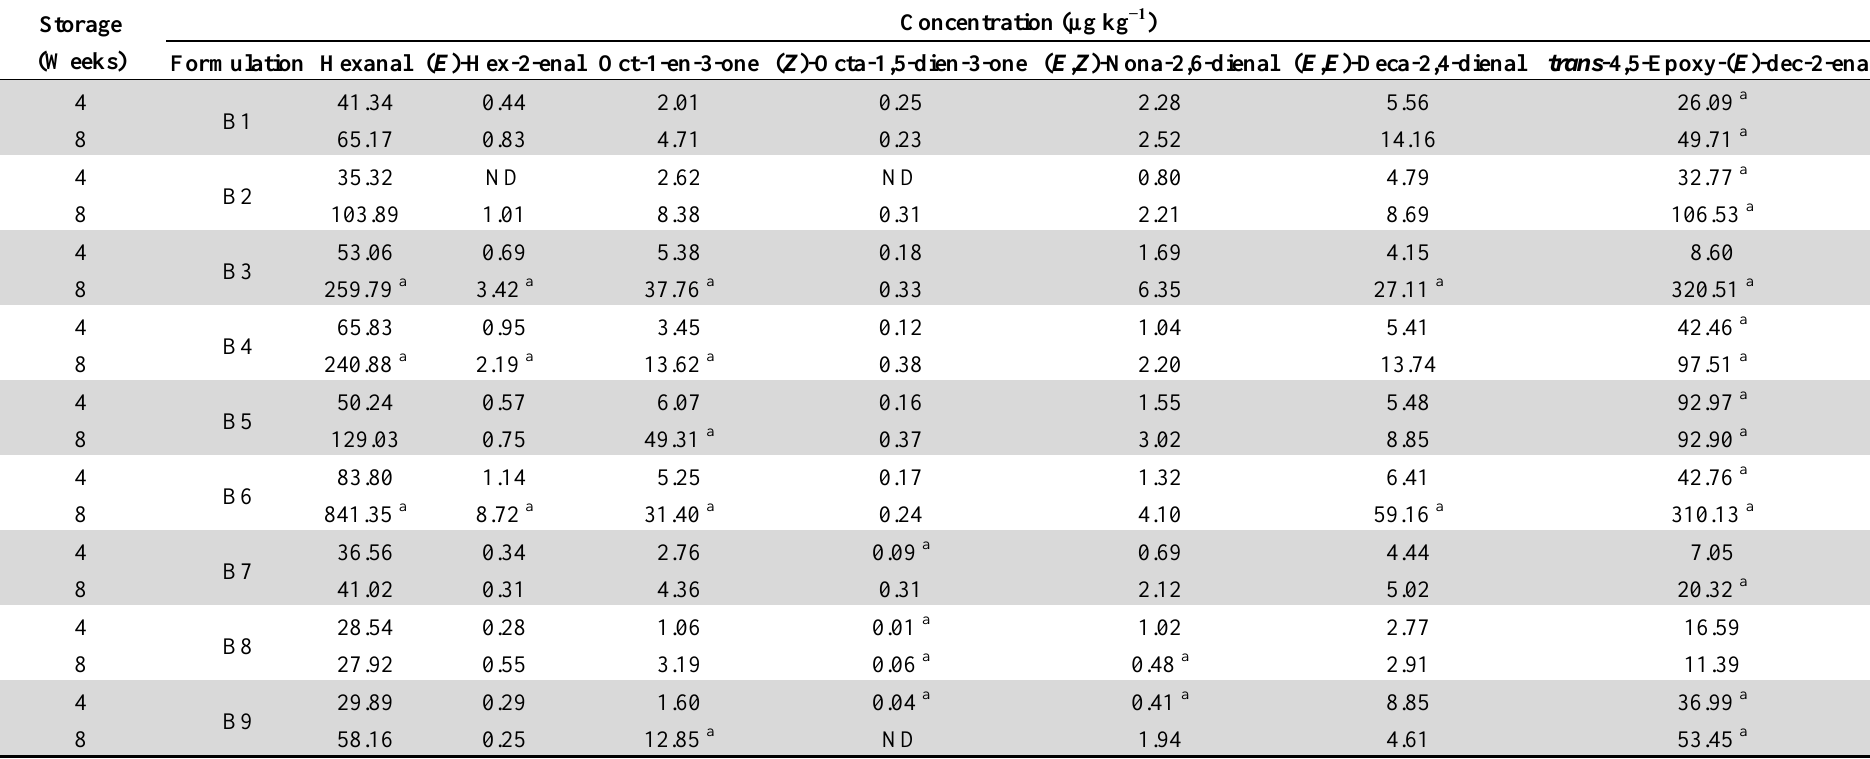
Table 6. Quantification of selected odorants in infant formulations after four and eight weeks of storage without antioxidants.